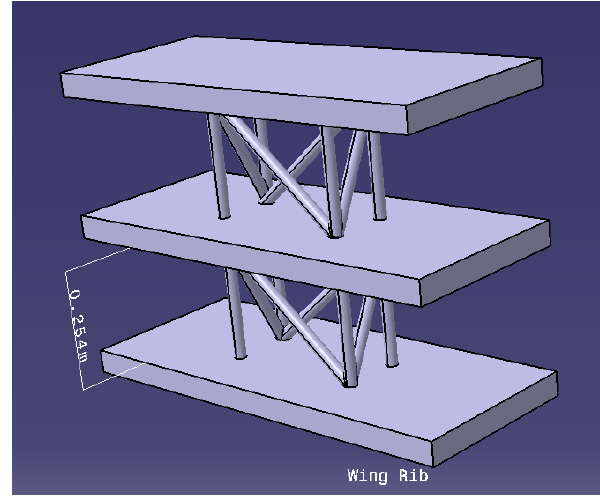
Figure 2. CAD model of the morphing wing.